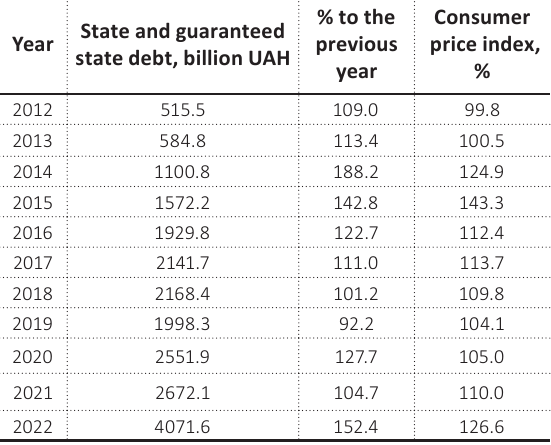
Table 2. Consumer price index, state and guaranteed state debt of